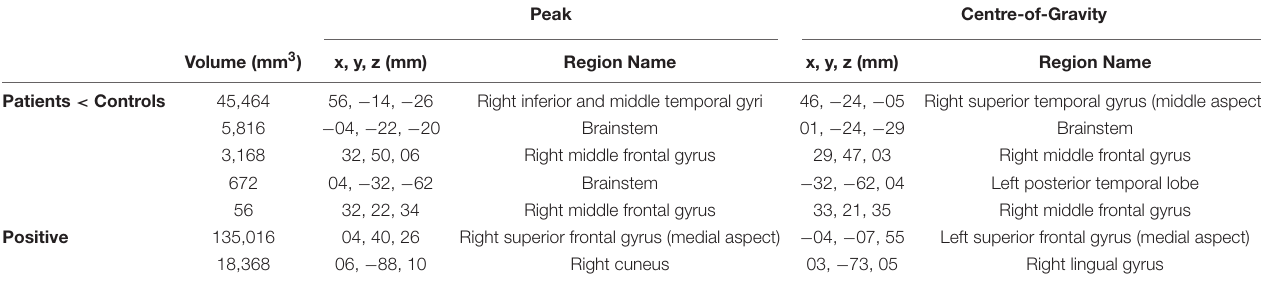
TABLE 3 | Clusters of significantly lower and higher [ 18 F]FDG uptake in patients, relative to healthy controls.